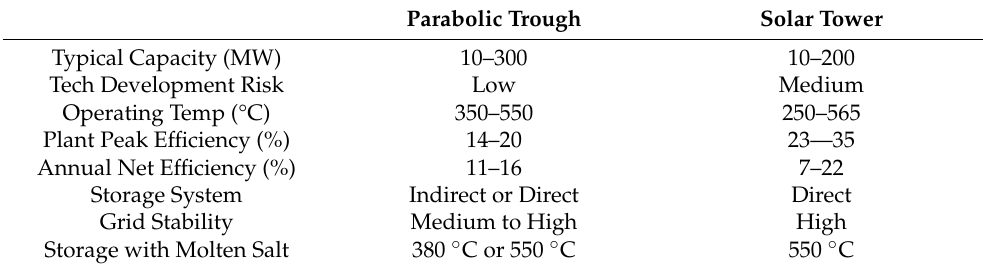
Table 1. Specific energy and storage requirements for different green energy systems [7].